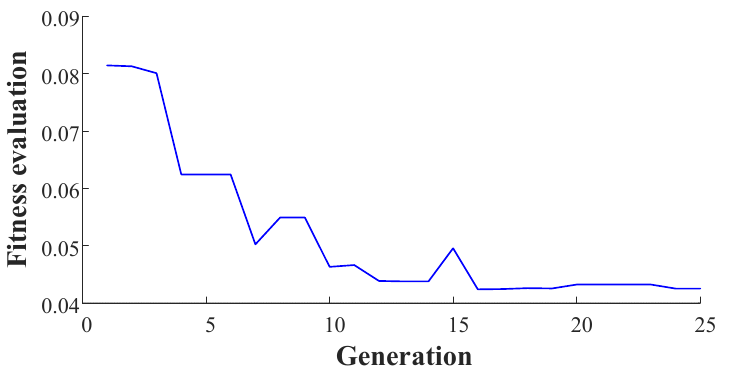
Figure 10. Evolution of the NMSE in terms of generation.